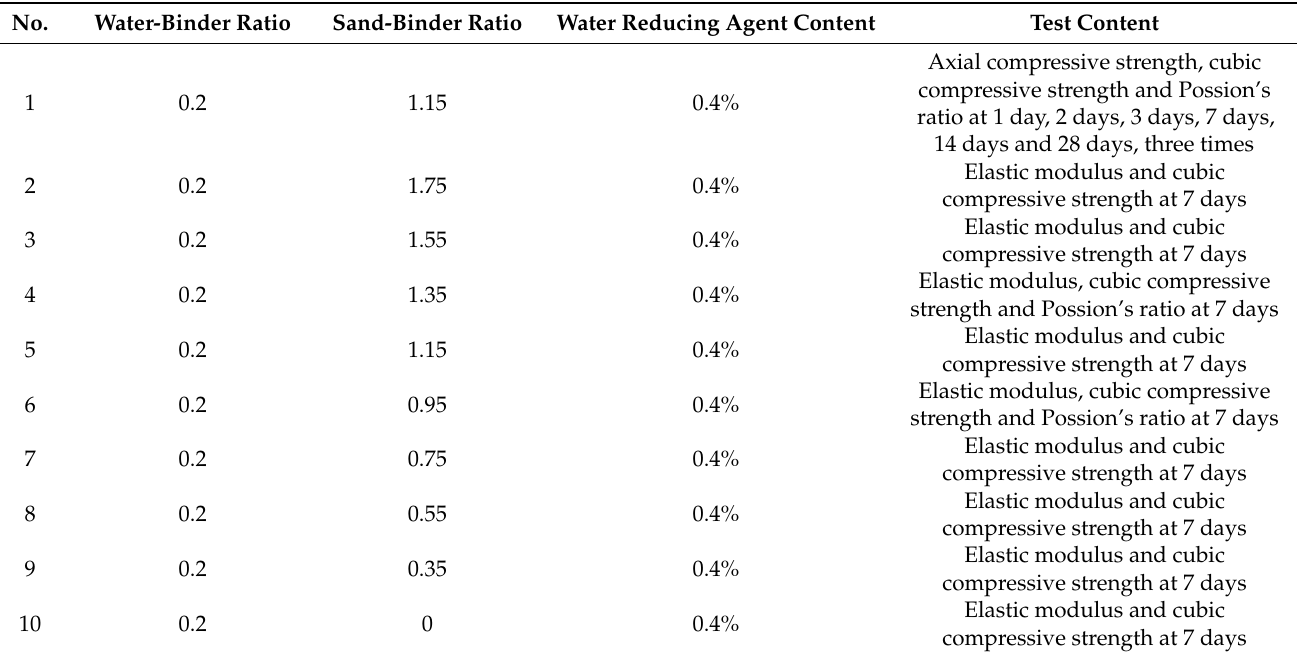
Table 4. The design of the